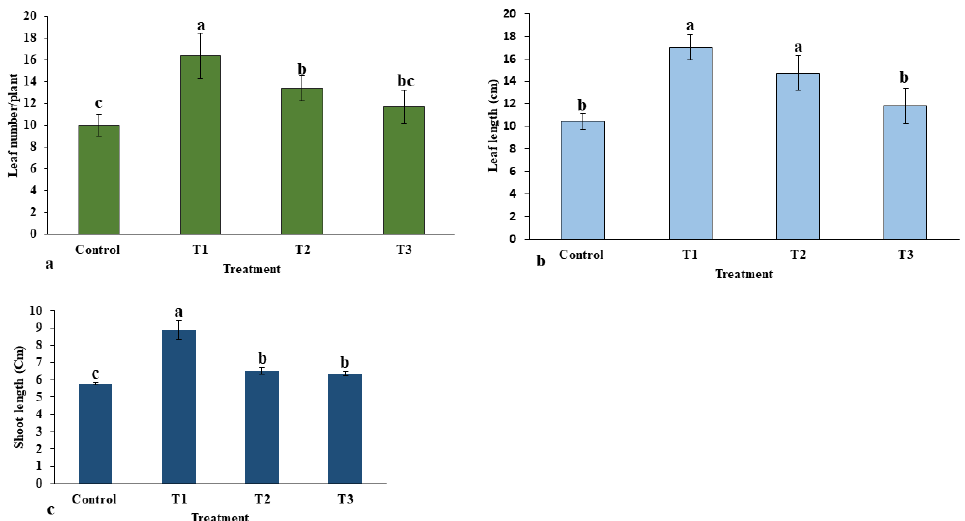
Figure 5. Effect of ZnO-NPs on morphological traits of E. macrochaetus : ( a ) leaf number; ( b ) leaf length; ( c ) shoot length. Treatments including control (0 mg/L, ZnO-NPs); T1 (10 mg/L, ZnO-NPs); T2 (20 mg/L, ZnO-NPs) and T3 (40 mg/L, ZnO-NPs). Different letters represent the significant values according to Duncan test at level p <